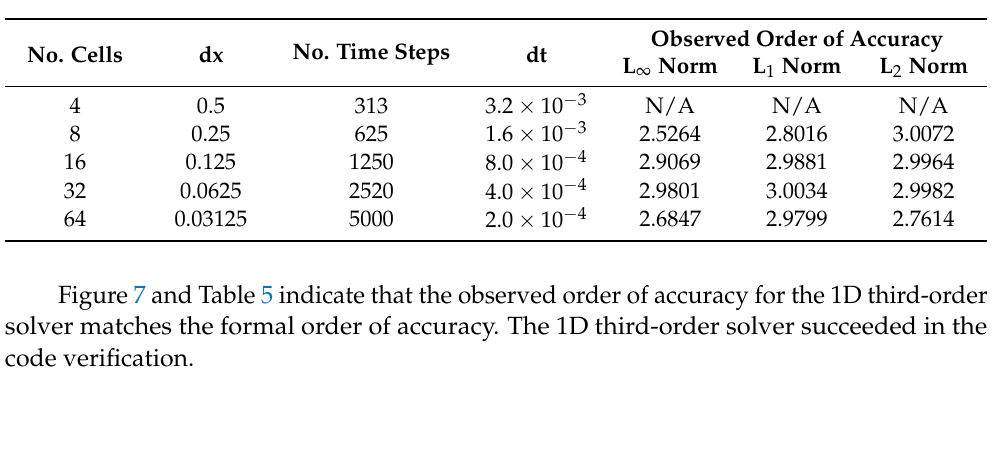
Figure 7. Observed order of accuracy of the 1D third-order solver ( left : error norm; right : observed order of accuracy). Table 5. Observed order of accuracy of the 1D third-order solver.